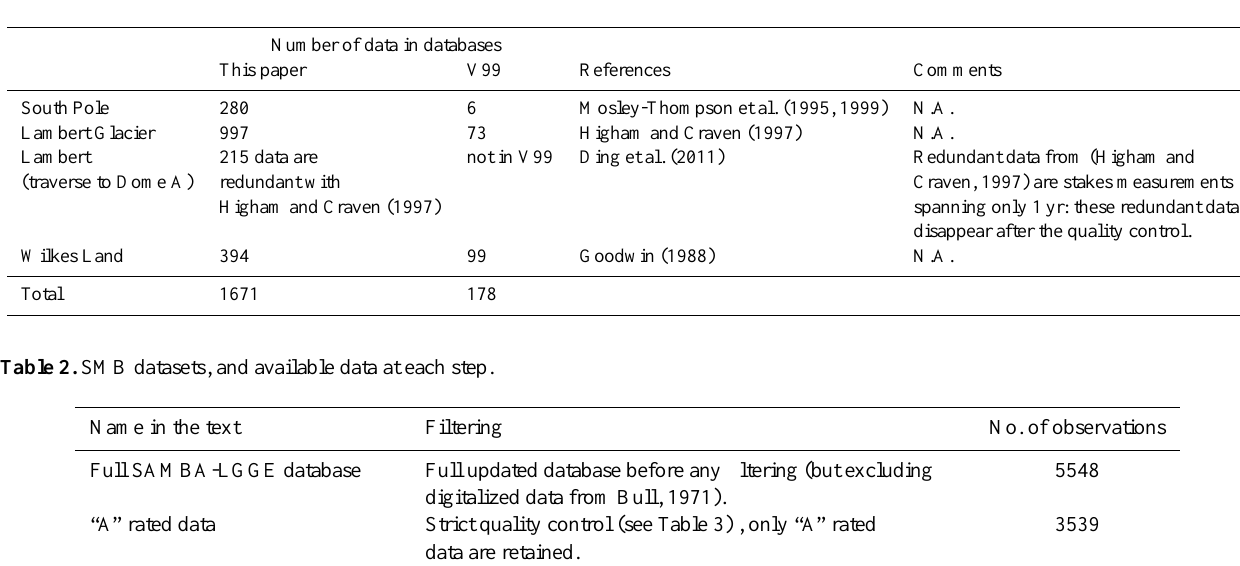
Table 1. List of sectors where data are presented separately instead of their average over 20 × 20km 2 grid cells given in V99. Number of data in databases This paper